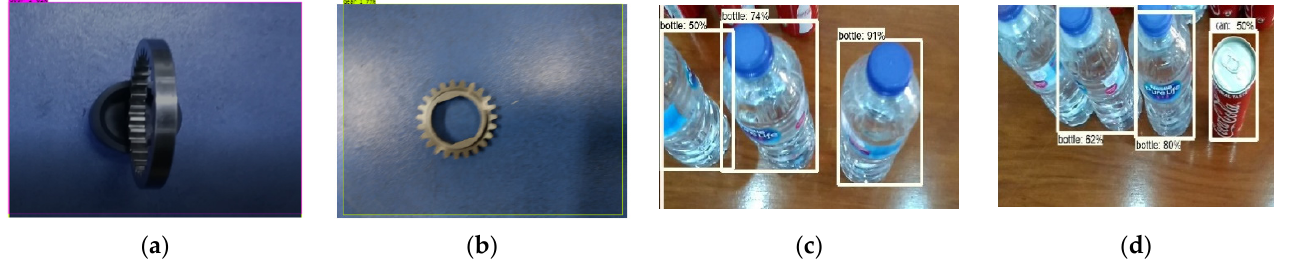
Figure 5. Detection of objects through object detection algorithm, ( a ) gear 1; ( b ) gear 2; ( c ) bottles; ( d ) cans.